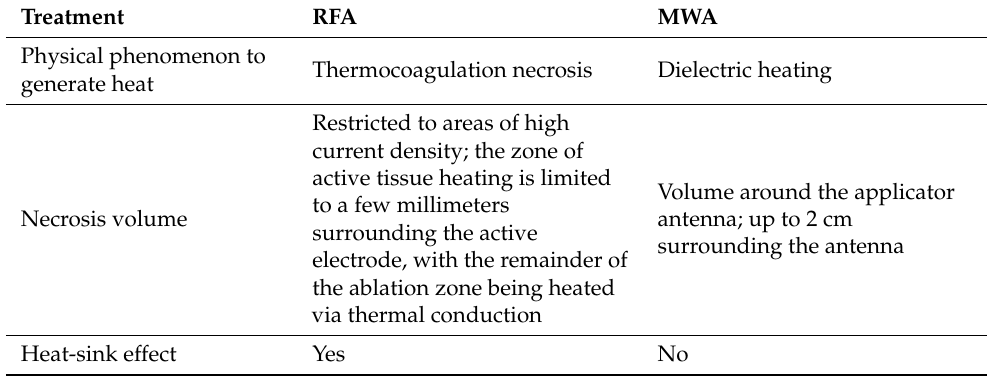
Table 1. RFA and MWA